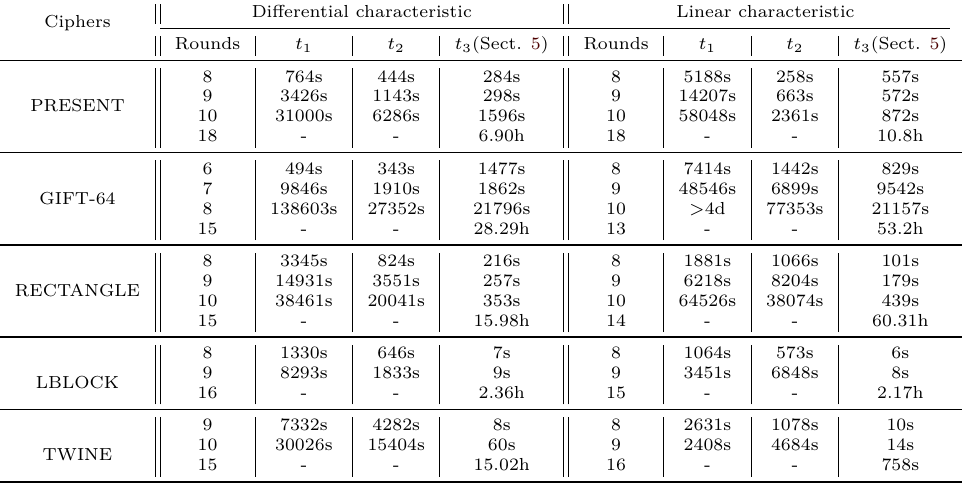
Table 1: Comparison of the results on the best differential and linear characteristics